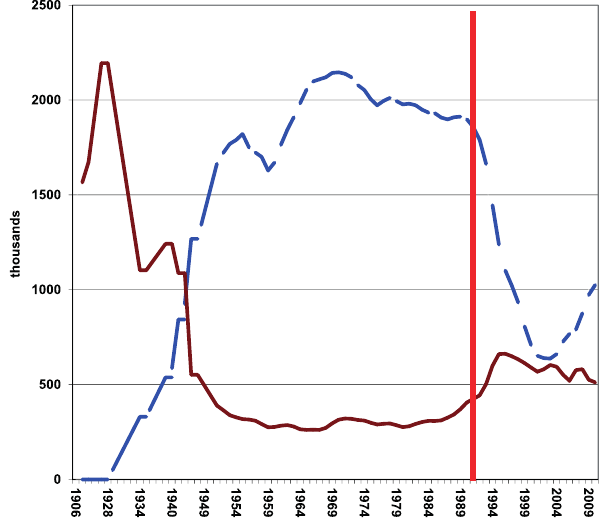
Fig. 3. A comparison of domesticated reindeer numbers in different forms of ownership in Russia. During Soviet and post-Soviet periods, reindeer populations within enterprises (REs - - - ) and households (RHs — ) were quite different and sometimes even opposite to each other. All reindeer were owned by reindeer herders until 1928 when reindeer-herding enterprises were first created. Collective enterprises (kolkhoz- es) were formed after collectivization. Later kolkhozes were transformed into state enterprises (sovkhozes). From 1960 to the 1980s, reindeer enterprises (kolkhozes and sovkhozes) owned about 85-90% of the total number of domesticated reindeer, and herding households owned the rest. In the first post-soviet decade some reindeer were privatized back into households. Since 2004 the number of reindeer in enterprises has increased due to an increase in state support. However the state does not support family